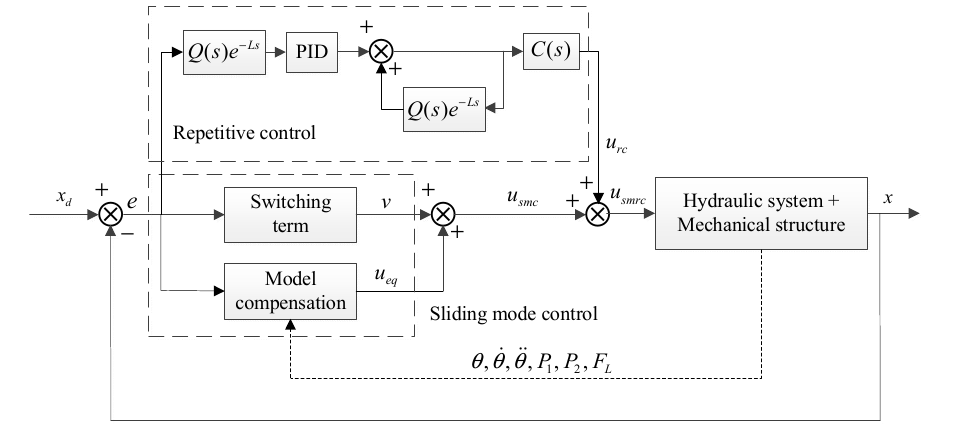
Figure 6. The block diagram of SMRC.